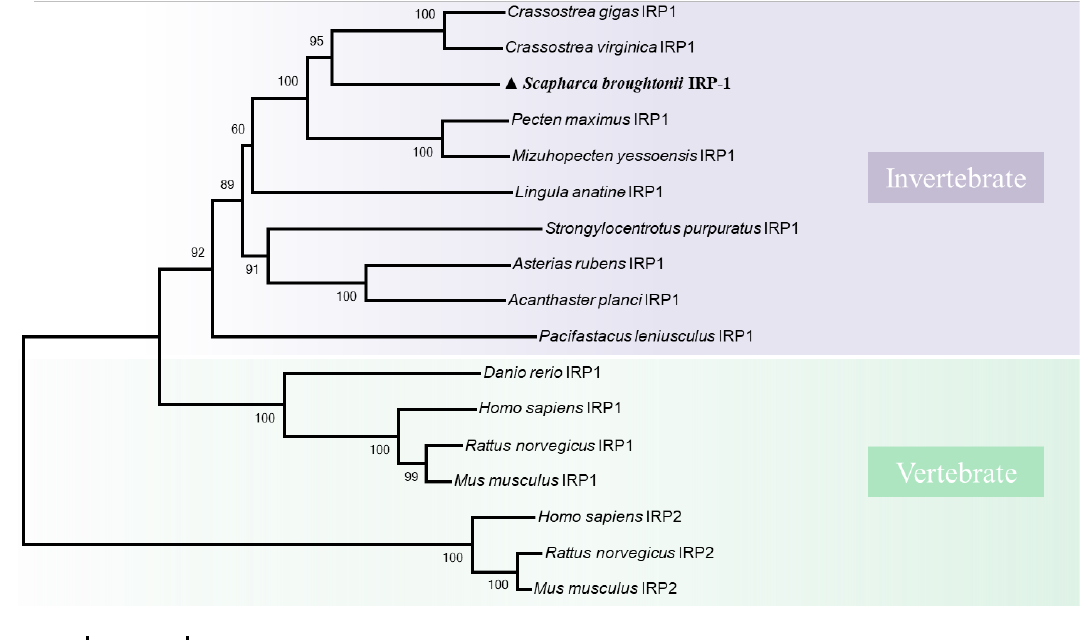
Figure 4. Phylogenetic tree of Sb IRP-1 and other known IRP family members. The tree was obtained using MEGA 6.0 with the neighbor-joining method. The numbers at the branches indicate the boot- strap value for 1,000 replicates. The accession numbers of these proteins obtained from GenBank are as follows: Crassostrea gigas IRP1 (XP_034321625.1), C.virginica IRP1 (XP_022311890.1), Pecten maxi- mus IRP1 (XP_033725425.1), M.yessoensis IRP1 (XP_021340677.1), Lingula anatine IRP1 (XP_013409788.1), Strongylocentrotus purpuratus IRP1 (XP_030855986.1), Asterias rubens IRP1